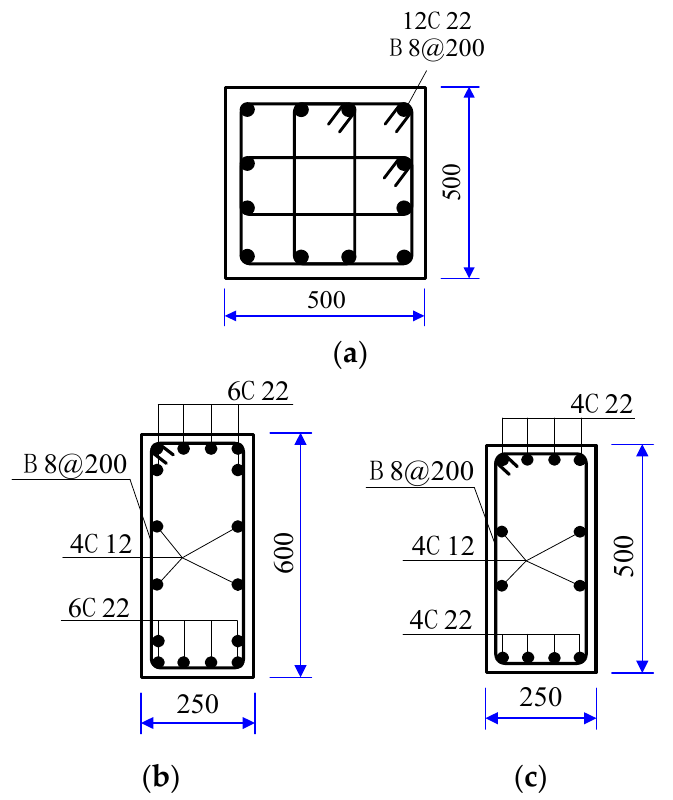
Figure 7. Reinforcement of the beams and columns (unit: mm). ( a ) Column; ( b ) X directional beam; ( c ) Y directional beam.